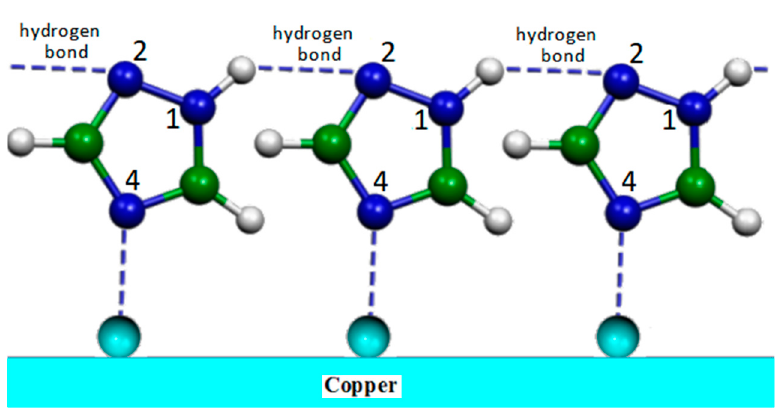
Figure 8. Adsorption model of the 1,2,4-triazole molecule on the copper substrate.